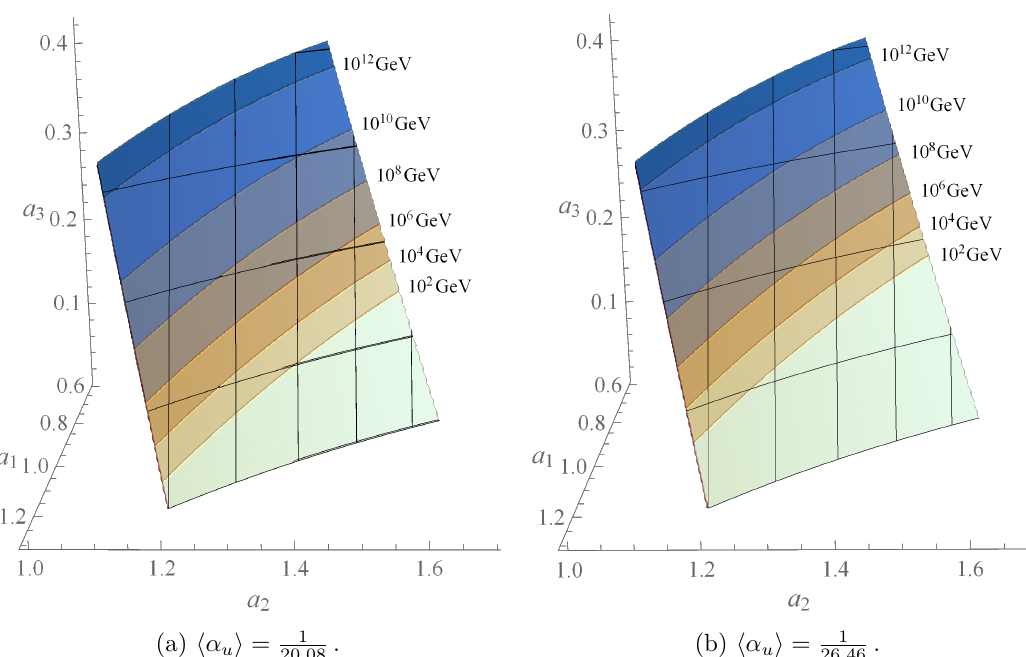
of the soft breaking terms across Figure 2 : Variation of the mass scale m ∼ 8 π Λ 3 /M 2 susy p the “viable” region of Kähler moduli space that satisfies all constraints in section 2, for the line bundle L = O (2 , 1 , 3) . The numbers indicate the m value corresponding to each susy X contour. Figure 2(a) and figure 2(b) respectively, show the results for both the split and the simultaneous Wilson lines scenarios described in section 2. m scales below the EW susy scale ∼ 10 2 GeV become unphysically small and, therefore, are not